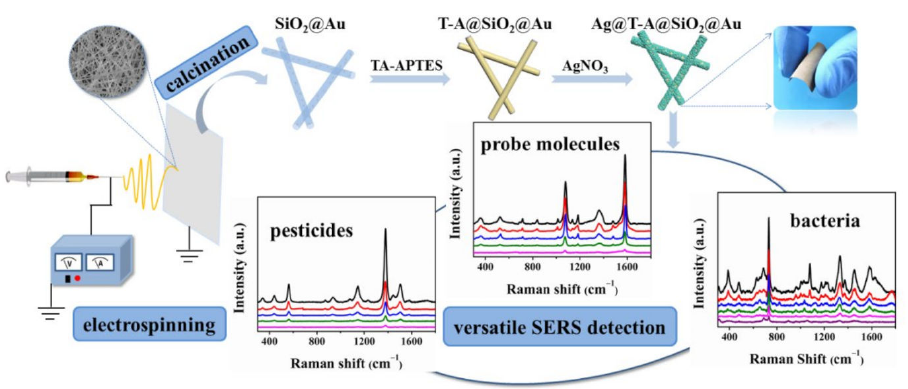
Figure 1. Schematic illustration of fabrication and surface-enhanced Raman scattering (SERS) activity for Ag@T-A@SiO 2 -Au nanofibrous